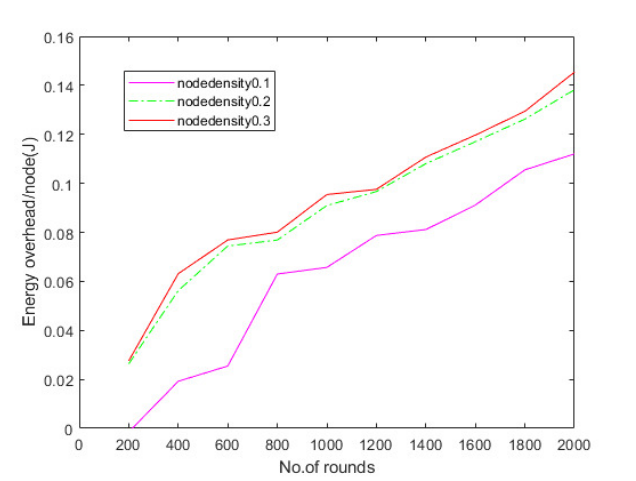
Figure 11. Comparative analysis of energy overhead for CETS at various node densities. Table 8. CETS versus other models on charging throughput per round at hop density